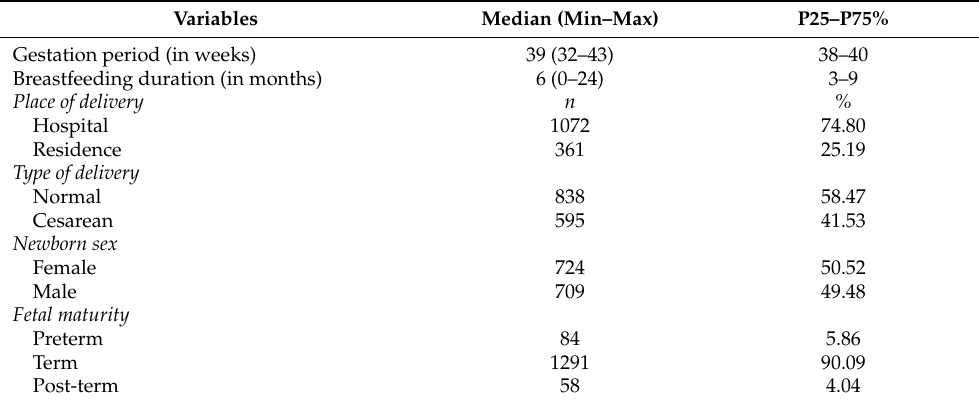
Table 2. Birth and duration of breastfeeding characteristics of studied women (n = 1433), Rond ô nia State, Brazilian Amazon.